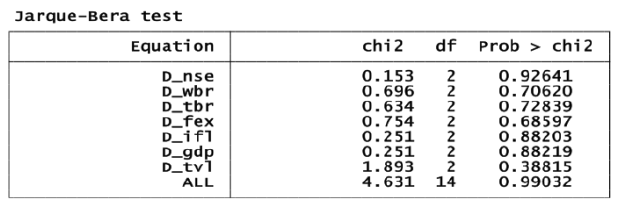
Table 2: Jarque-Bera Test results